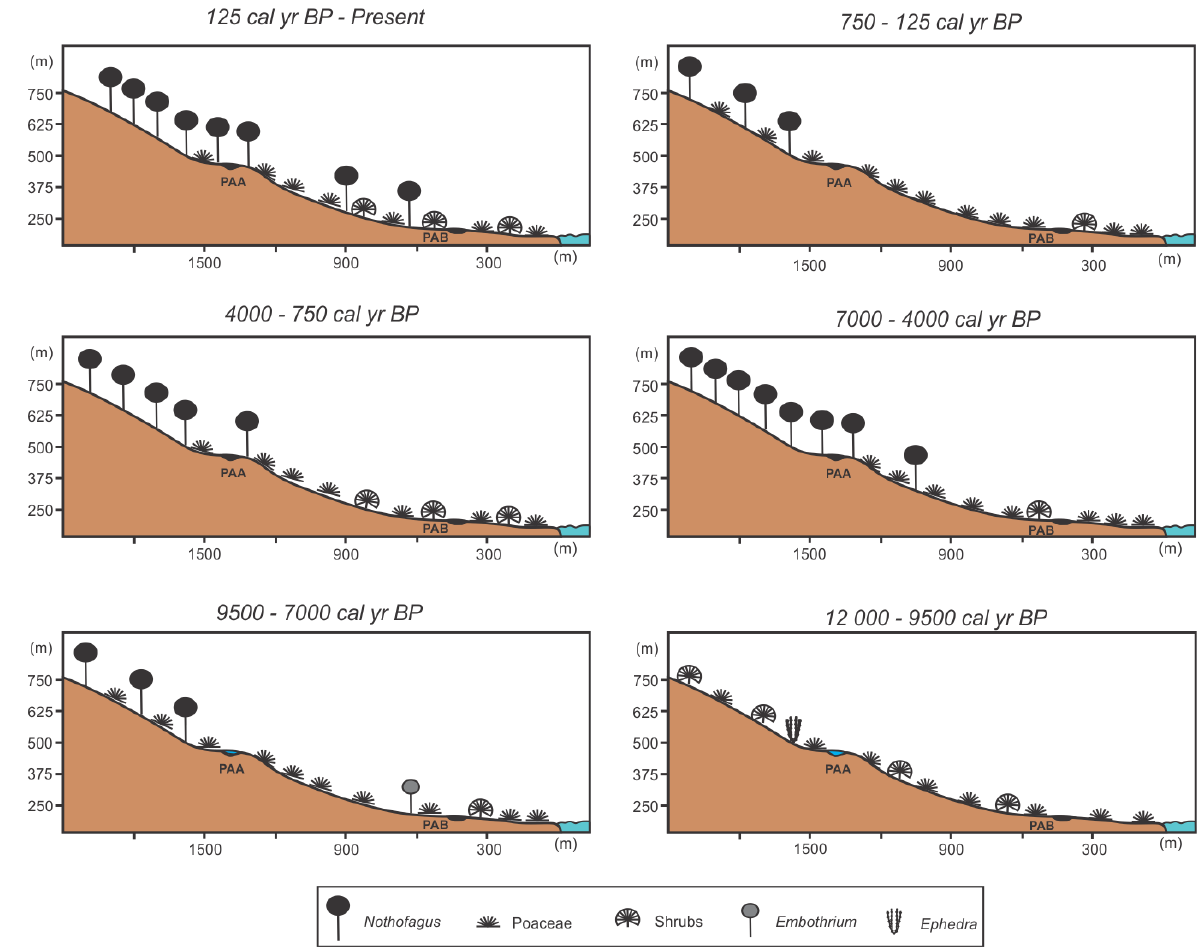
Figure 9. Reconstruction of postglacial vegetation communities at Península